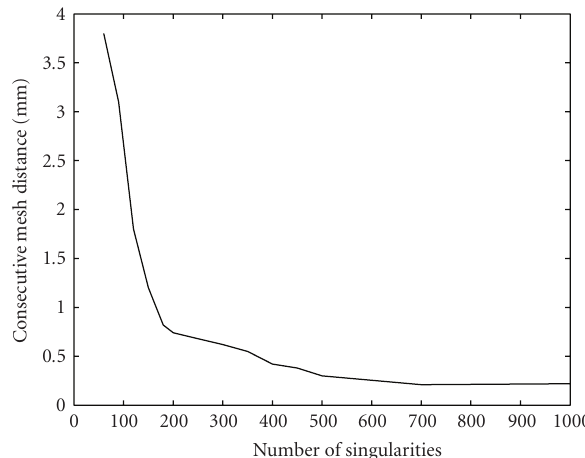
Figure 3: Average distance between consecutive meshes as a function of the number of